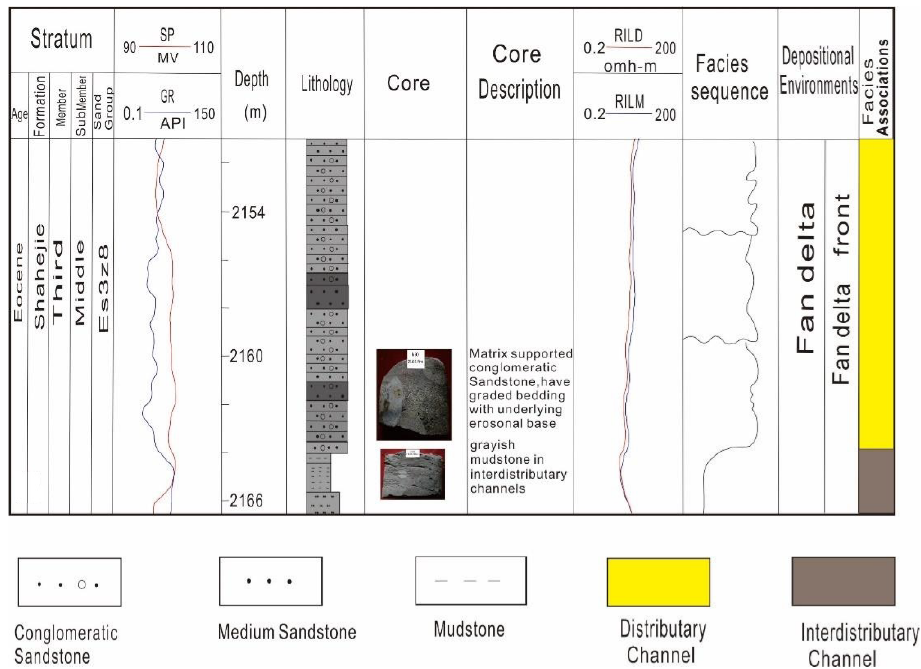
Figure 4. Core well k50 in the study area illustrating facies of the Inner fan delta front, rep resenting trend of log suits with lithology, core, and sedimentary facies. Cores of those dispatched are shown in (Table 1).